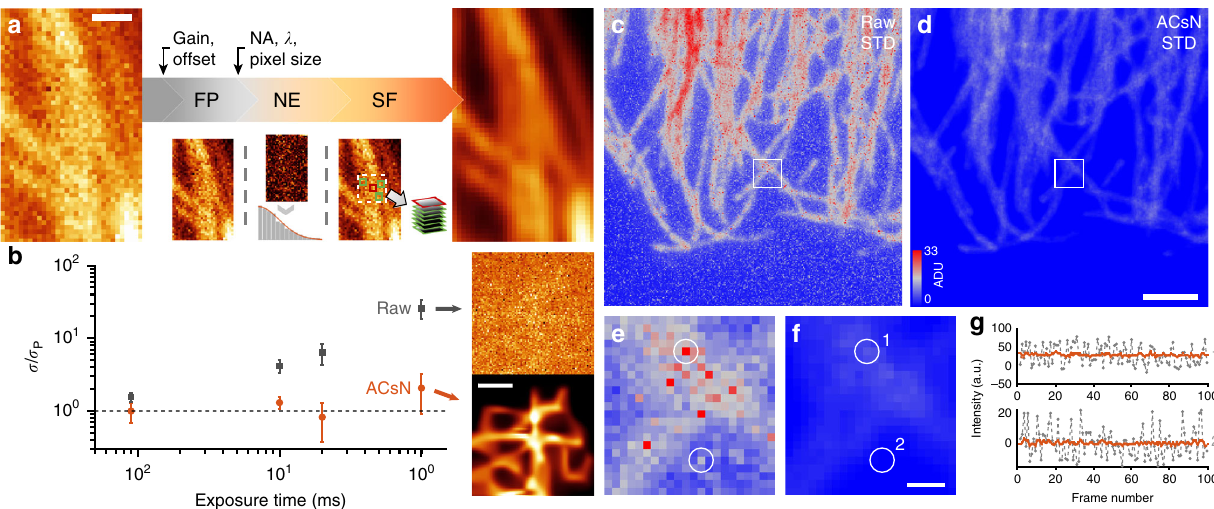
Fig. 1 ACsN concept and performance. a Concept of the ACsN algorithm. The input image is scaled with the pixel gain and offset maps of the camera in order to remove the fi xed-pattern noise (FP). Then, using the experimental parameters, the OTF boundary is calculated and used to produce a high-pass fi ltered image, from which the noise estimation (NE) is obtained. Finally, sparse fi ltering (SF) is performed to generate the denoised image. b Comparison of noise variations before (gray squares) and after (red circles) noise correction. All data were divided by the expected value for pure Poisson noise. The dashed line represents the ideal camera performance. To generate this plot three different sets of images of HeLa microtubules were used. The error bars represent the temporal standard deviation (STD) evaluated over 100 images. c , d Fluctuation maps, i.e., STD evaluated over 100 sCMOS images acquired at a 10-ms exposure time before ( c ) and after ( d ) ACsN denoising. Intensities are expressed in analog-to-digital units (ADU). e , f Zoomed-in images of the areas marked by the white squares in c and d , respectively. g Temporal fl uctuation of the intensity values of the pixels corresponding to the circled areas (1 and 2) in e and f , respectively. The values from the original and denoised images are plotted in gray and red, respectively. Scale bars: 500 nm ( a ), 1 µ m ( b ), 3 µ m ( d ), 300 nm ( f